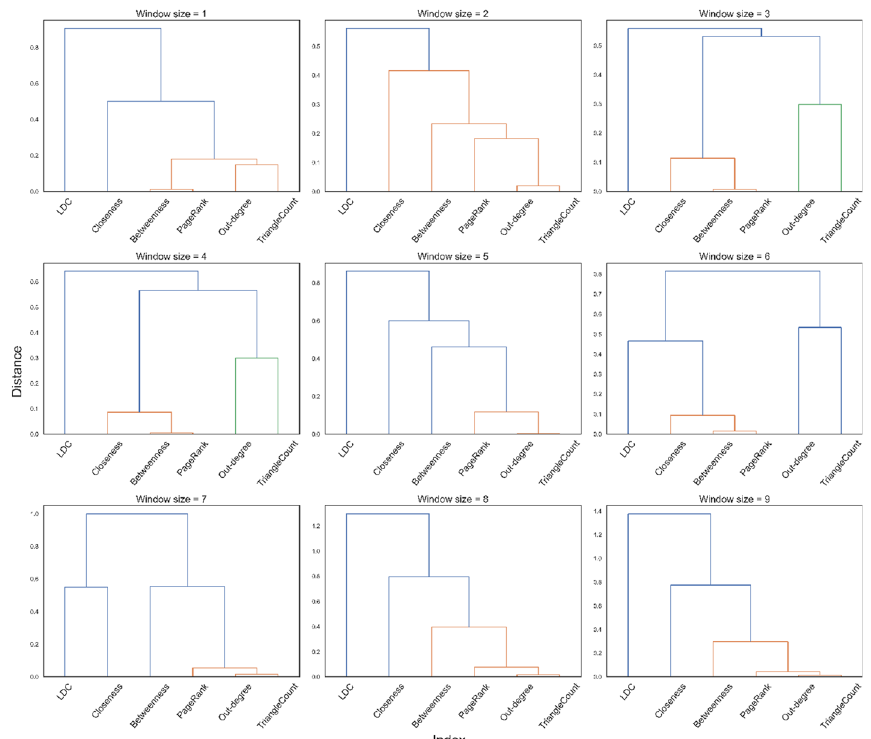
Fig. 4 Visualization of the hierarchical clustering. Each plot represents a dendrogram for a given WS value. MS was equal to 13 in all